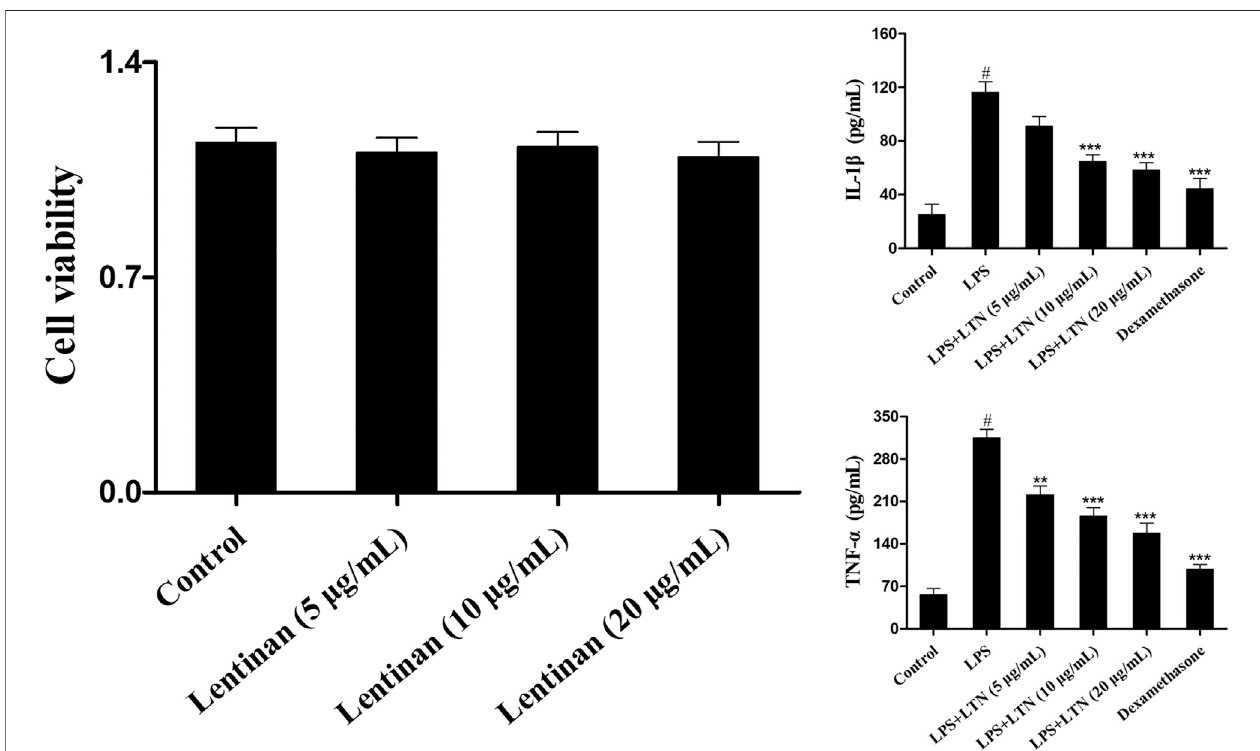
FIGURE 6 | Effects of lentinan on in fl ammatory response of LPS-induced mouse mammary epithelial cells. (A) The potential cytotoxicity of lentinan (5, 10, and 20 μ g/ml)onmMECswasdetectedbyMTTexperiment. (B) TheTNF- α andIL-1 β proteinlevelsweredetectedusingtheELISAkitinLPS-stimulatedmMECs.Alldataare represented as the mean ± S.E.M.of three replicates.* p < 0.05 vs. the LPS group. ** p < 0.01 compared with theLPS group. *** p < 0.01 compared with the LPS